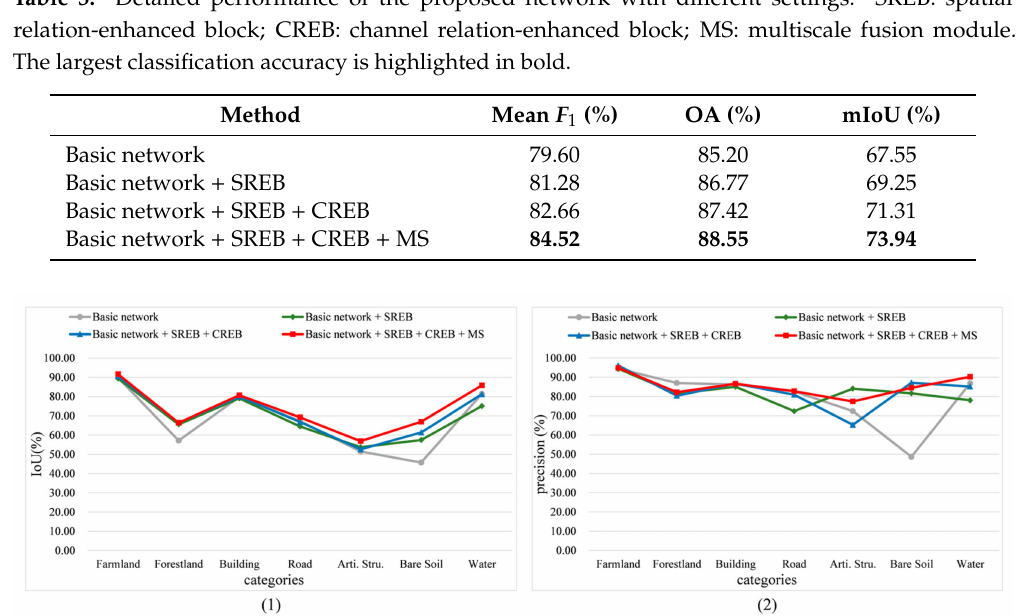
Figure 11. Intersection-over-union (IoU) and precision changes of per class with di ff erent settings. (1) Changes of per class IoU with di ff erent settings; (2) changes of per class precision with di ff erent settings. SREB: spatial relation-enhanced block; CREB: channel relation-enhanced block; MS: multiscale fusion module.